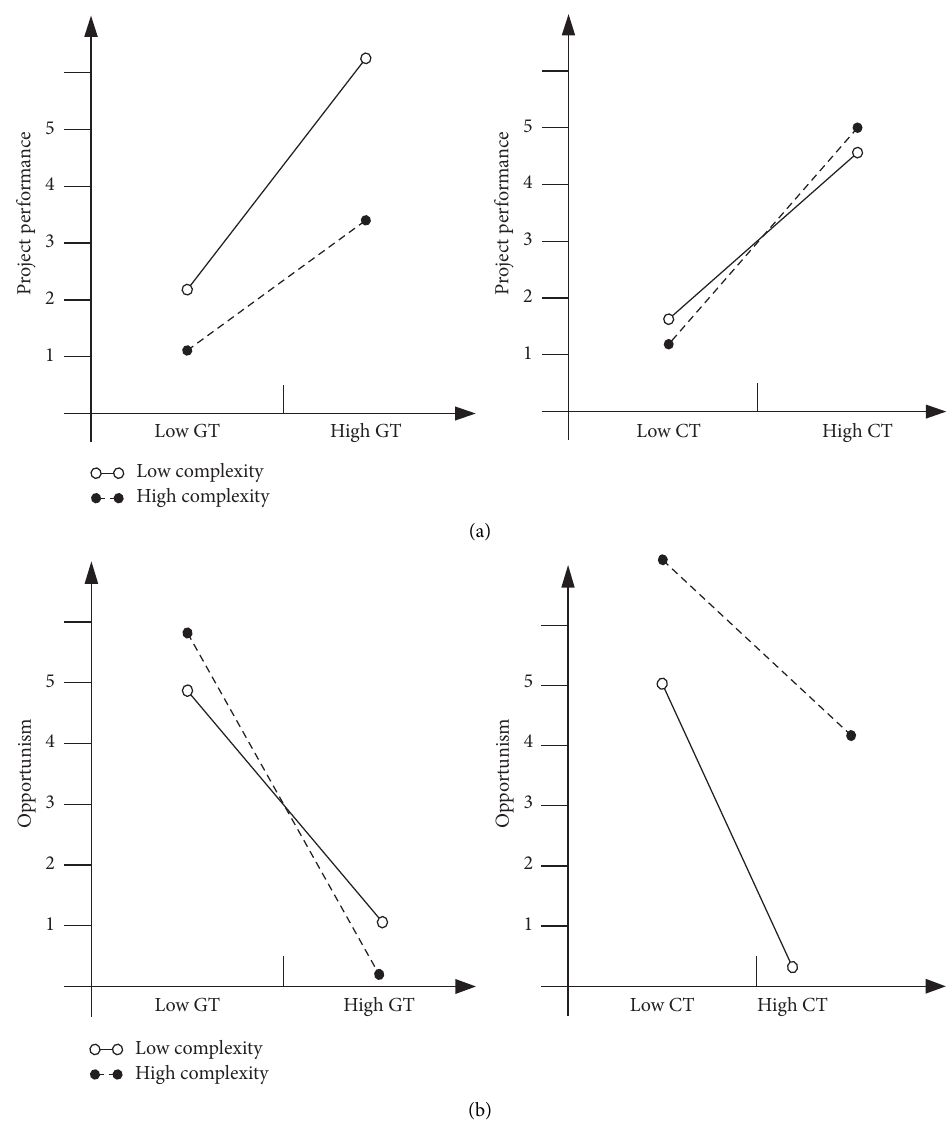
Figure 3: Graphical representation of moderation effects. (a) Impact of trust on project performance. (b) Impact of trust on opportunism. Notes: CT, competence-based trust; GT, goodwill-based